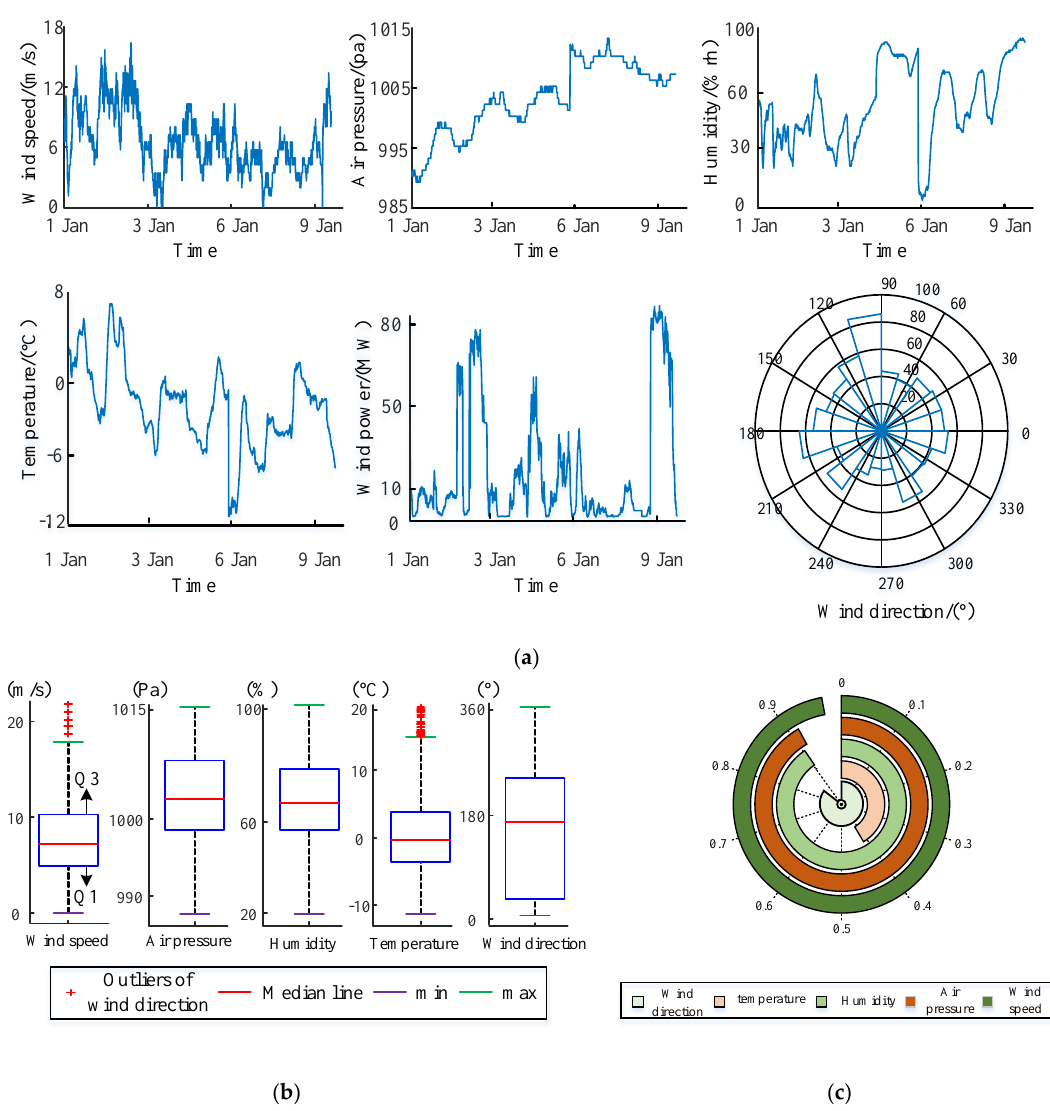
Figure 3. Data analysis charts. ( a ) original data visualization; ( b ) Box diagram of input weather variables; ( c ) Stacked histogram of input weather variables.